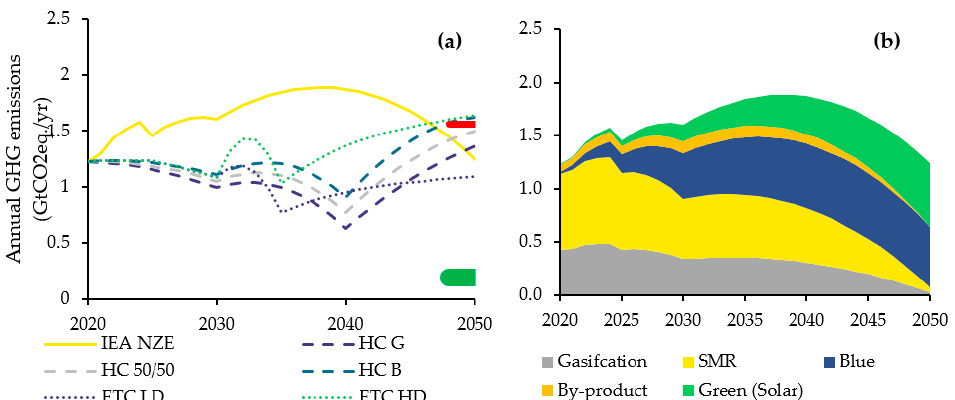
Figure 1. ( a ) Annual GHG emissions from hydrogen demand by model and scenario. The red line extending from 2050 represents the IEA’s estimations for cumulative carbon capture in 2050. ( b ) Annual GHG emissions from hydrogen demand from the IEA NZE scenario (this scenario was used because it was the scenario with the greatest available data with the least use of assumptions) dis- aggregated by hydrogen production type as an example of the internal composition of the emission from each production type. It can be seen that the total of ( b ) aligns with the curve shown in ( a ) for the IEA NZE scenario (by-product hydrogen was assumed to have the same emission factor as gray